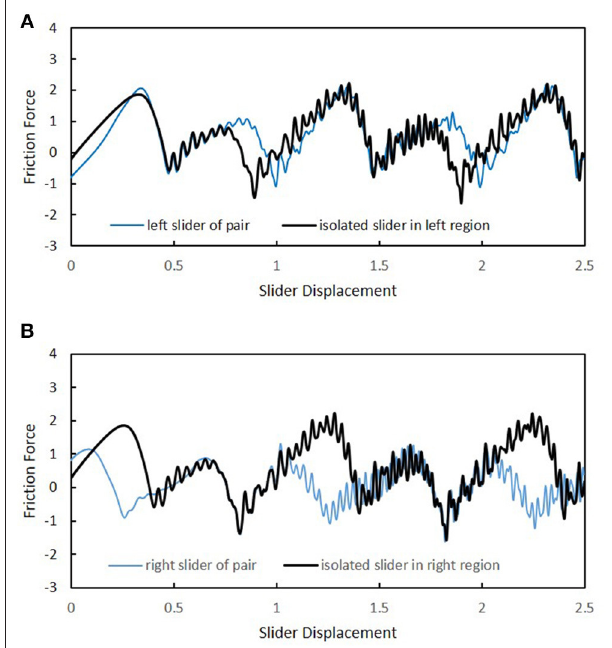
FIGURE 11 | Comparison of slider friction in cases with and without a pairing slider. Pair is separated by 3 √ 2 along the x- axis. (A) Friction experienced by left slider of pair and by isolated slider at same locations. (B) Friction experienced by right slider of pair and by isolated slider at same locations.